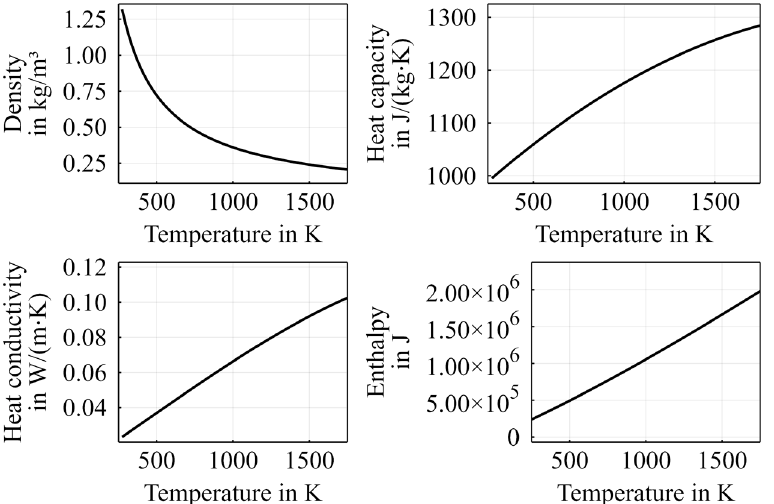
Figure 3. Thermophysical properties of the off-gas (70 vol.-% N 2 , 10 vol.-% CO 2 and 20 vol.-% CO).